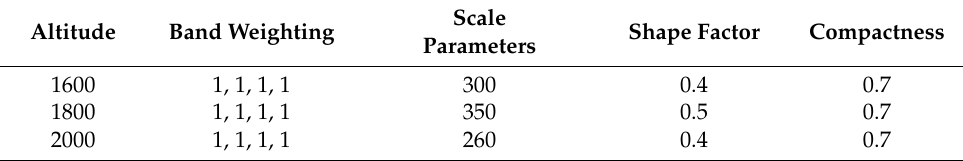
Table 3. Optimal combinations of segmentation